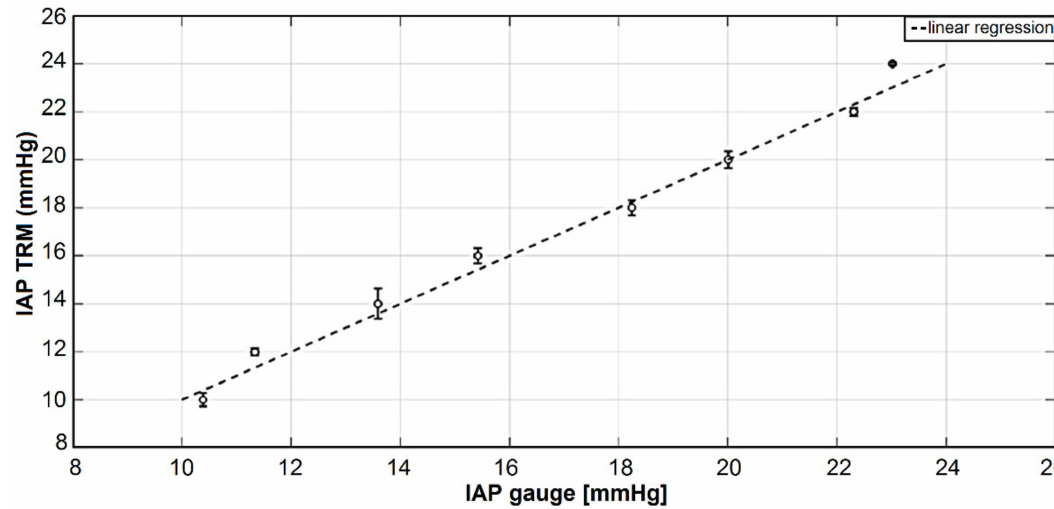
Figure 7. Results of the test measurements obtained after calibrating the TRM system compared with the reference pressure values according to the pressure gauge. As illustrated, the standard deviation values are relatively larger at lower IAP values compared with IAP values higher than 18 mmHg. The main reason for this could be that the displacement variation is higher than the thickness variations in the abdominal wall phantom. Since, at low IAP values, the displacement of the abdominal wall is the main changing parameter, greater standard deviations are obtained at low IAP values.